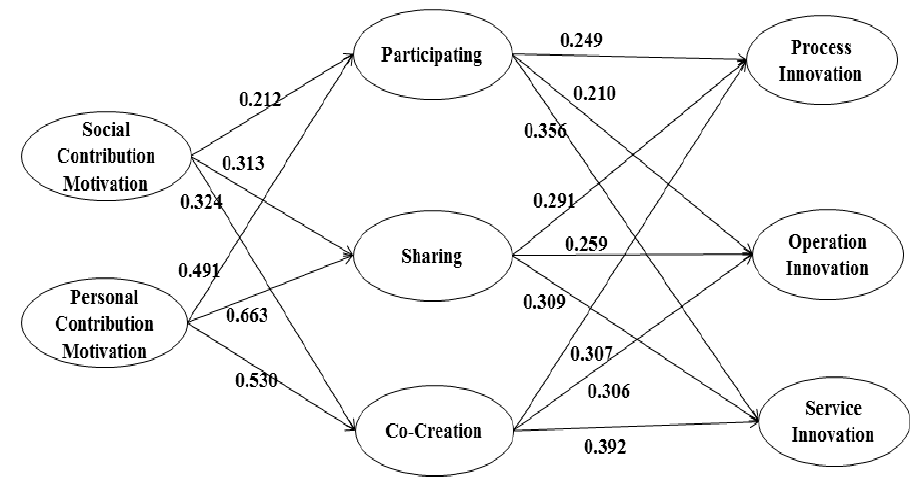
Figure 2. Results of suggested research model with path coefficients.